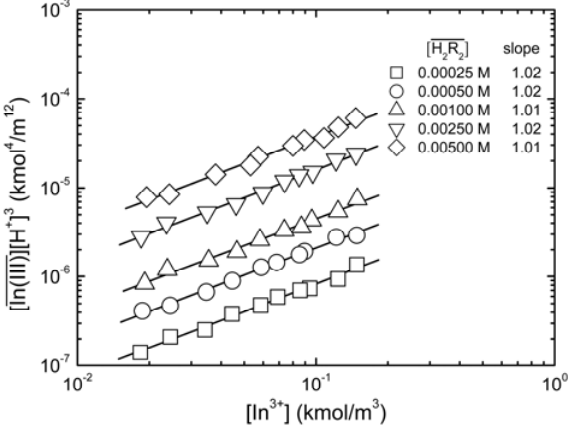
3 + at equilibrium with various D2EHPA In(III) vs. 3+ In     0.020 to 0.15 kmol/m 3 t